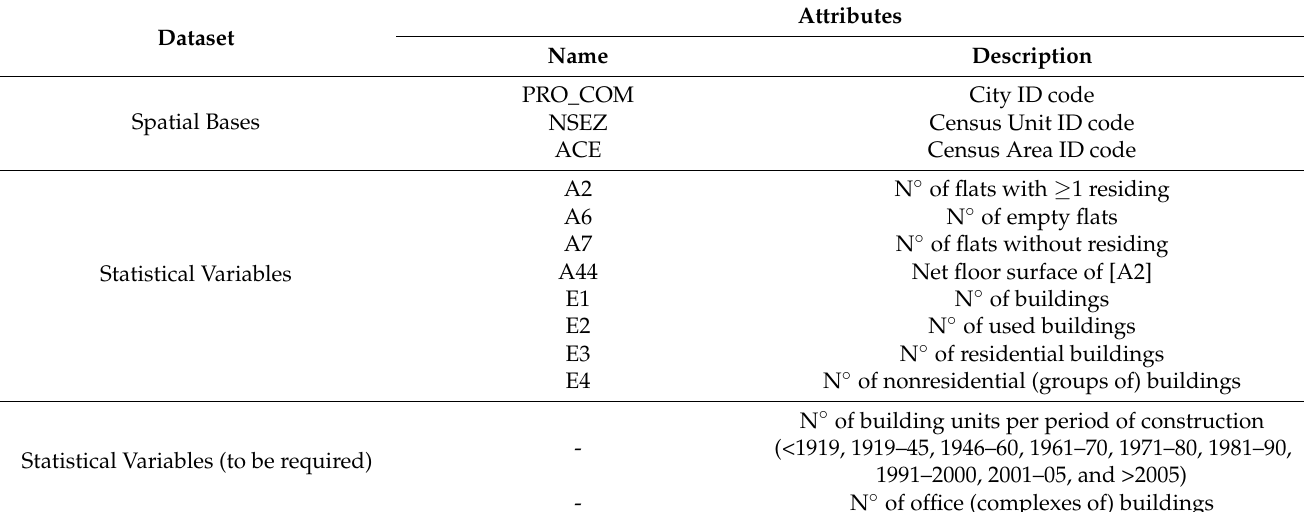
Table 3. Adopted spatial datasets and used Attributes from the 15th General Census of Population and Houses. Dataset